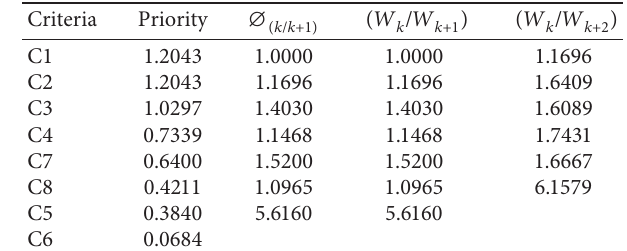
Table 8: Comparative priority of the